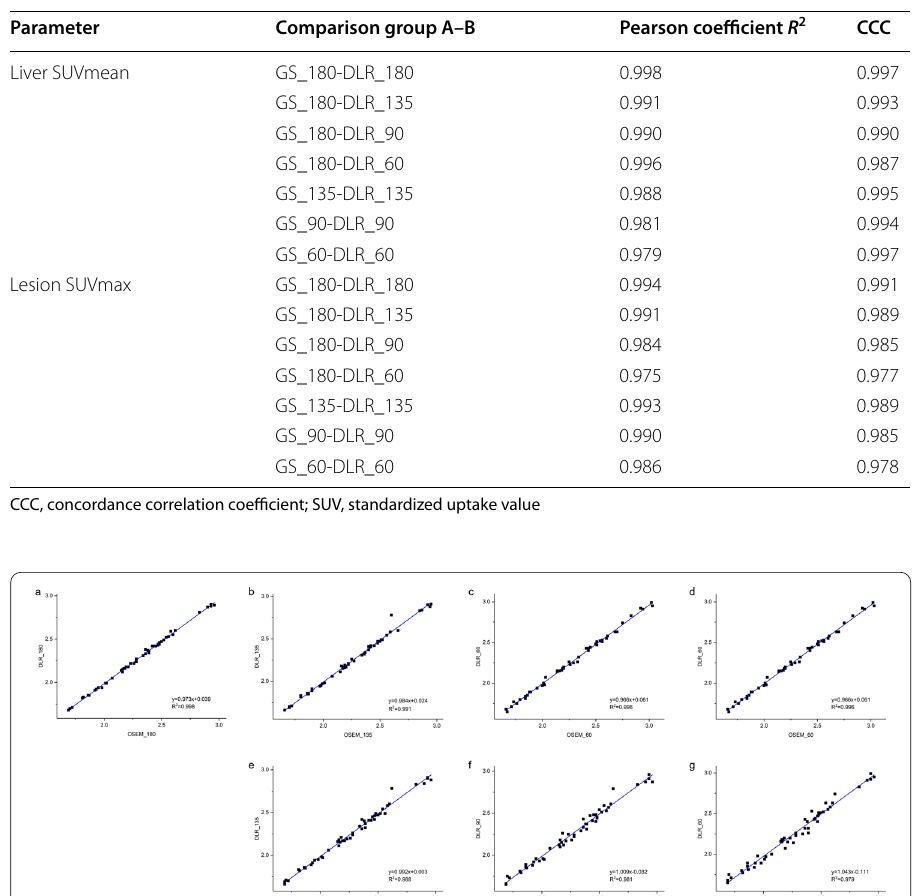
Table 3 Differences in SUV of liver and lesion tissues Parameter Comparison group A–B